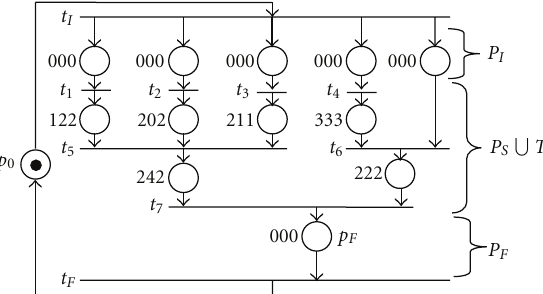
Figure 1: Process net with needs for three resource types.